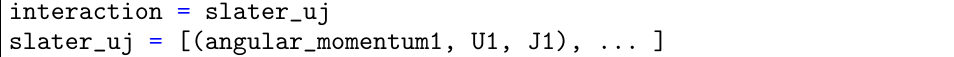
Table 2: Formula of the effective Slater integrals for